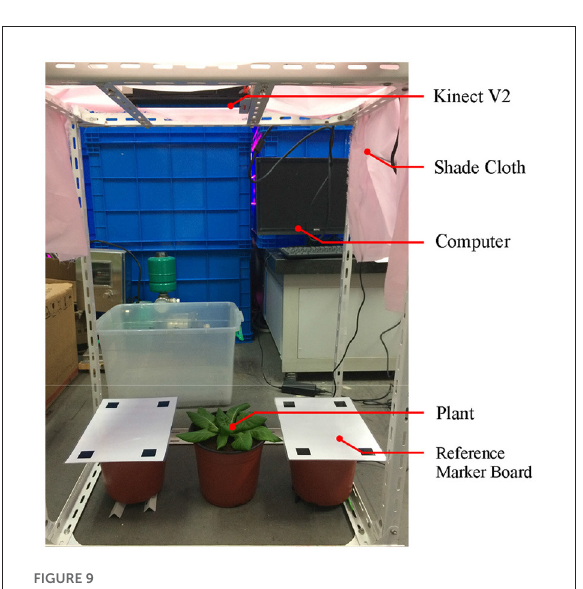
FIGURE9 Indoor static plant information collection